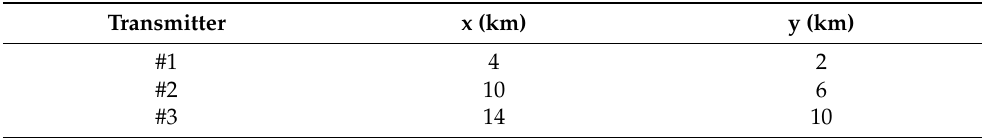
Table 4. Transmitting antennas positions.